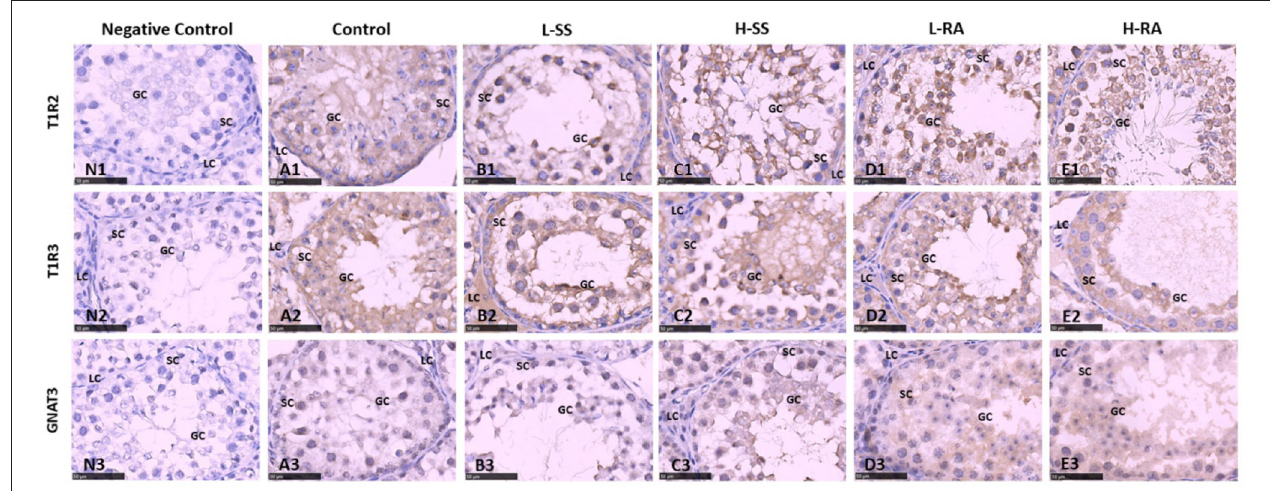
FIGURE 6 | Effect of dietary non-nutritive sweetness drinking on immunolocalization of the sweet-tasting molecules T1R2 (6A1–E1) , T1R3 (6A2–E2) , and GNAT3 (6A3–E3) in the seminiferous tubule of testis in male guinea pigs. Animals in the control, L-SS, H-SS, L-RA, and H-RA groups were supplied water solution with normal water, 1.5mM sodium saccharin, 7.5mM sodium saccharin, 0.5mM rebaudioside A, and 2.5mM rebaudioside A for 28 days, respectively. Tissues were sectioned at 4 µ m and immunostained with primary antibody to T1R2, T1R3, and GNAT3 proteins, and negative control was performed with NRS instead of primary antibody (6N1–N3) . Positive immunostaining in brown and counterstaining with hematoxylin. GC, germ cell; SC, Sertoli cell; LC, Leydig cell. Bars = 50 µ m.